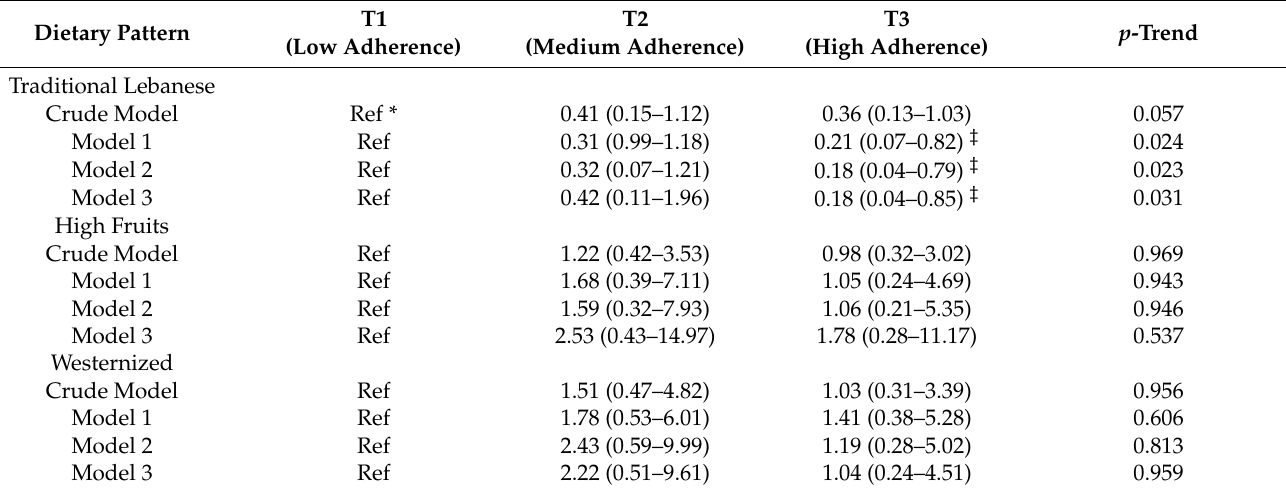
Table 4. Hepatic fibrosis across tertiles (T) of dietary pattern scores.